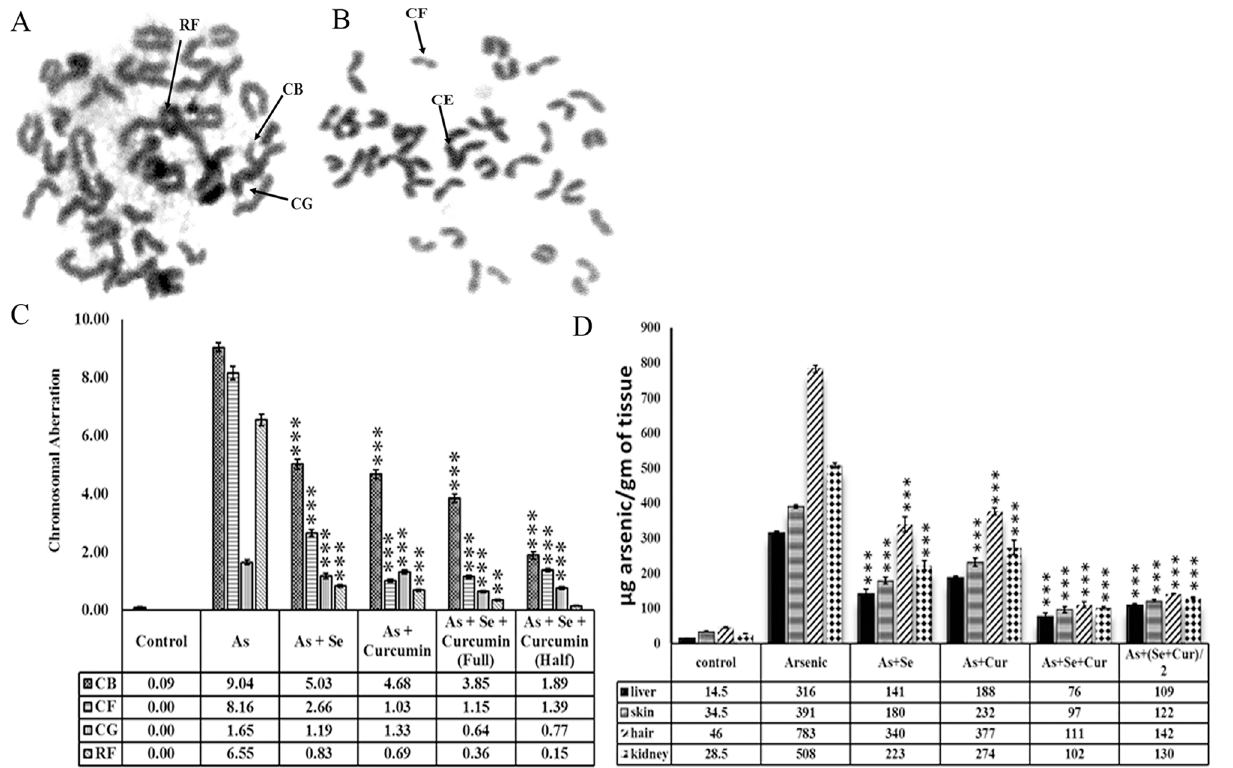
Fig 3. iAs in drinking water induced CA in 0 day old neonate mouse bone marrow cells after 8 – 18 day in utero exposure (A-C) and toxicant burden in hair, skin, liver and kidney of nulliparous female mice after 30 day oral administration (D) and rescue by PO administration of selenium and/or curcumin. Display of RF, CB, CG [A], CF [B], significant changes in formation of CB, CF and RF [C]; data are mean of three different experiments; ± SEM, ‘ p ’ values are *** < 0.001, ** < 0.01; [D] significant reduction in iAs burden after PO selenium and/or curcumin administration, data are expressed as mean of three different experiments; ± SEM, ‘ p ’ values are *** < 0.001, ** <